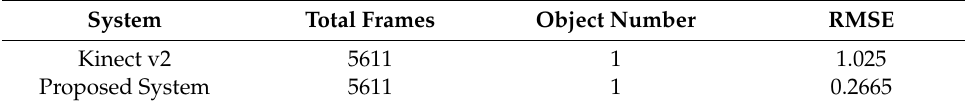
Table 1. Tracking Error Comparison Between Kinect v2 and Proposed System. Figure 6. Tacking Trajectory.